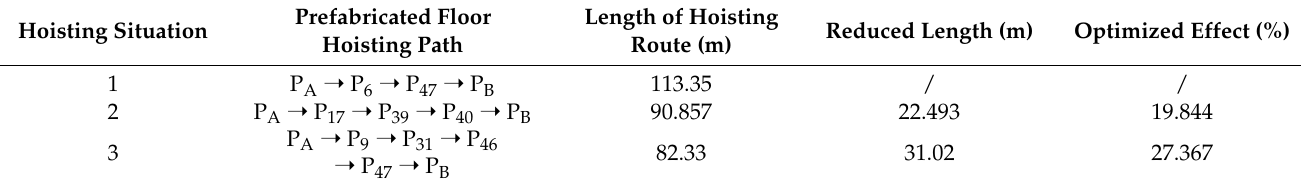
Figure 11. Physical view of LoRa information transmission terminal and gateway architecture. In the case study, the BIM hoisting model established was exported in IFC format, which was parsed and read in the JavaScript environment for extension and light-weight processing, and the developed interface was used for transmission and uploading to H DD .